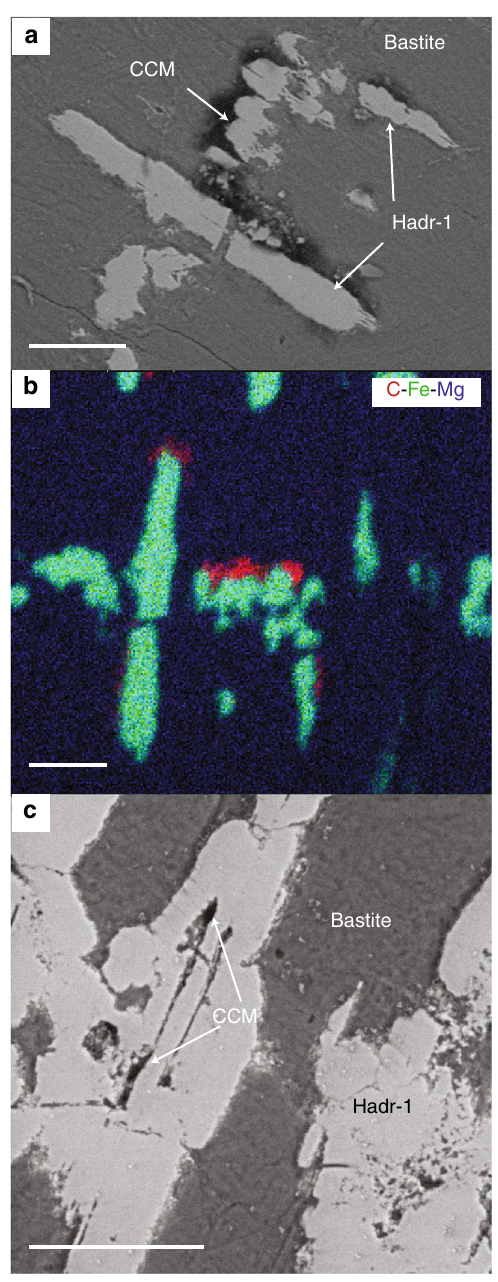
Fig. 3 Association of CCM with type 1-hydroandradite (Hadr-1) and bastite assemblage (BastHadr). a Backscattered electron SEM image showing a thin organic fi lm coating the surface of Hadr-1 growing subparallel to the exsolution planes of the primary pyroxene. b Associated elemental distributions of carbon (red), iron (green) and magnesium (blue). c Backscattered electron SEM image showing that CCM is also present in the cavities of Hadr-1. Scale bars correspond to 20 µ